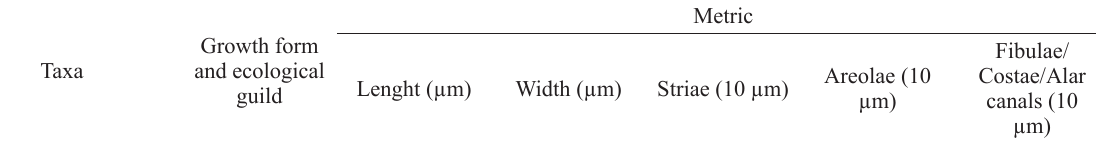
TABLE I Diatoms from Negro River, classification and